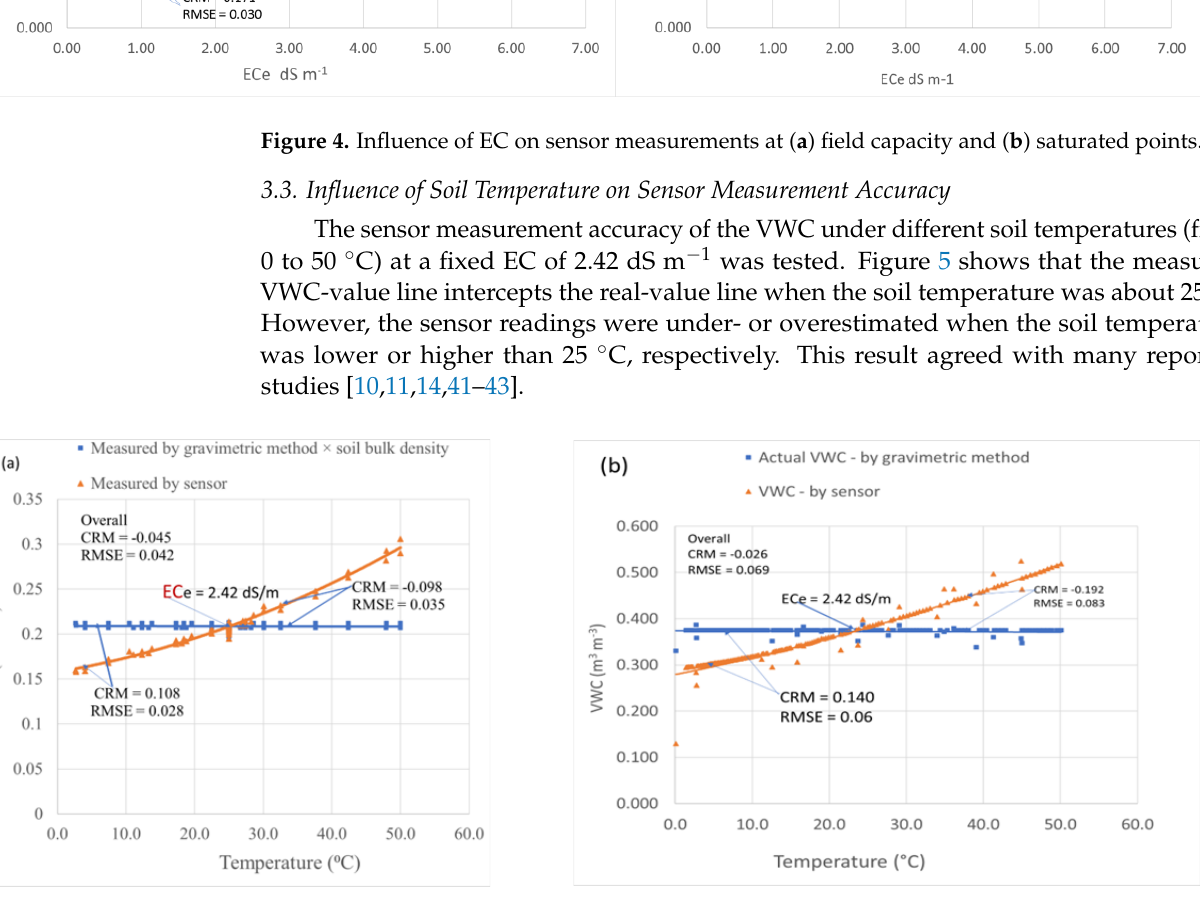
Figure 4. Influence of EC on sensor measurements at ( a ) field capacity and ( b ) saturated points.